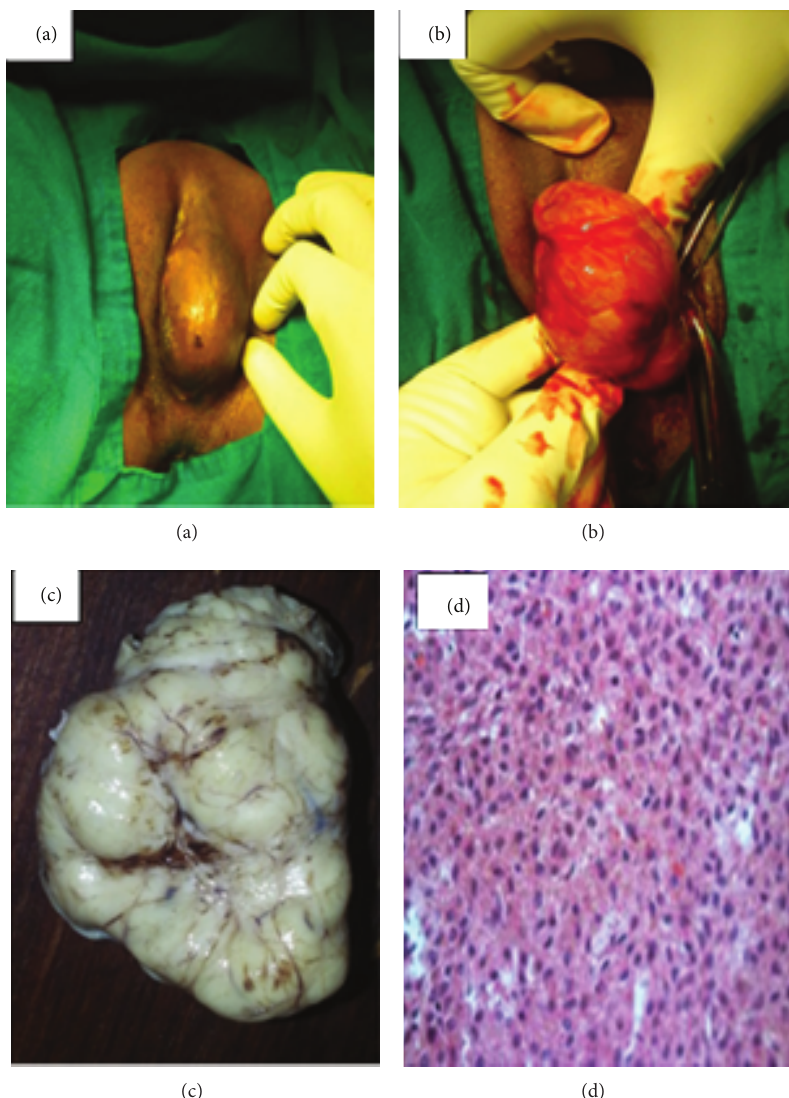
Figure 1: (a) Vulval swelling after the inflammation subsided. (b) Intraoperative: enucleation. (c) Gross specimen consisted of single, nodular, grey-white tissue mass weighing 56 gm; measures 6 × 4 × 3 cm. (d) Microscopy showing a benign tumor composed of sheets and fascicles of oval to spindle shaped cells with abundant dense cytoplasm, microcystic areas, areas of hyalinization, and focal lymphocytic